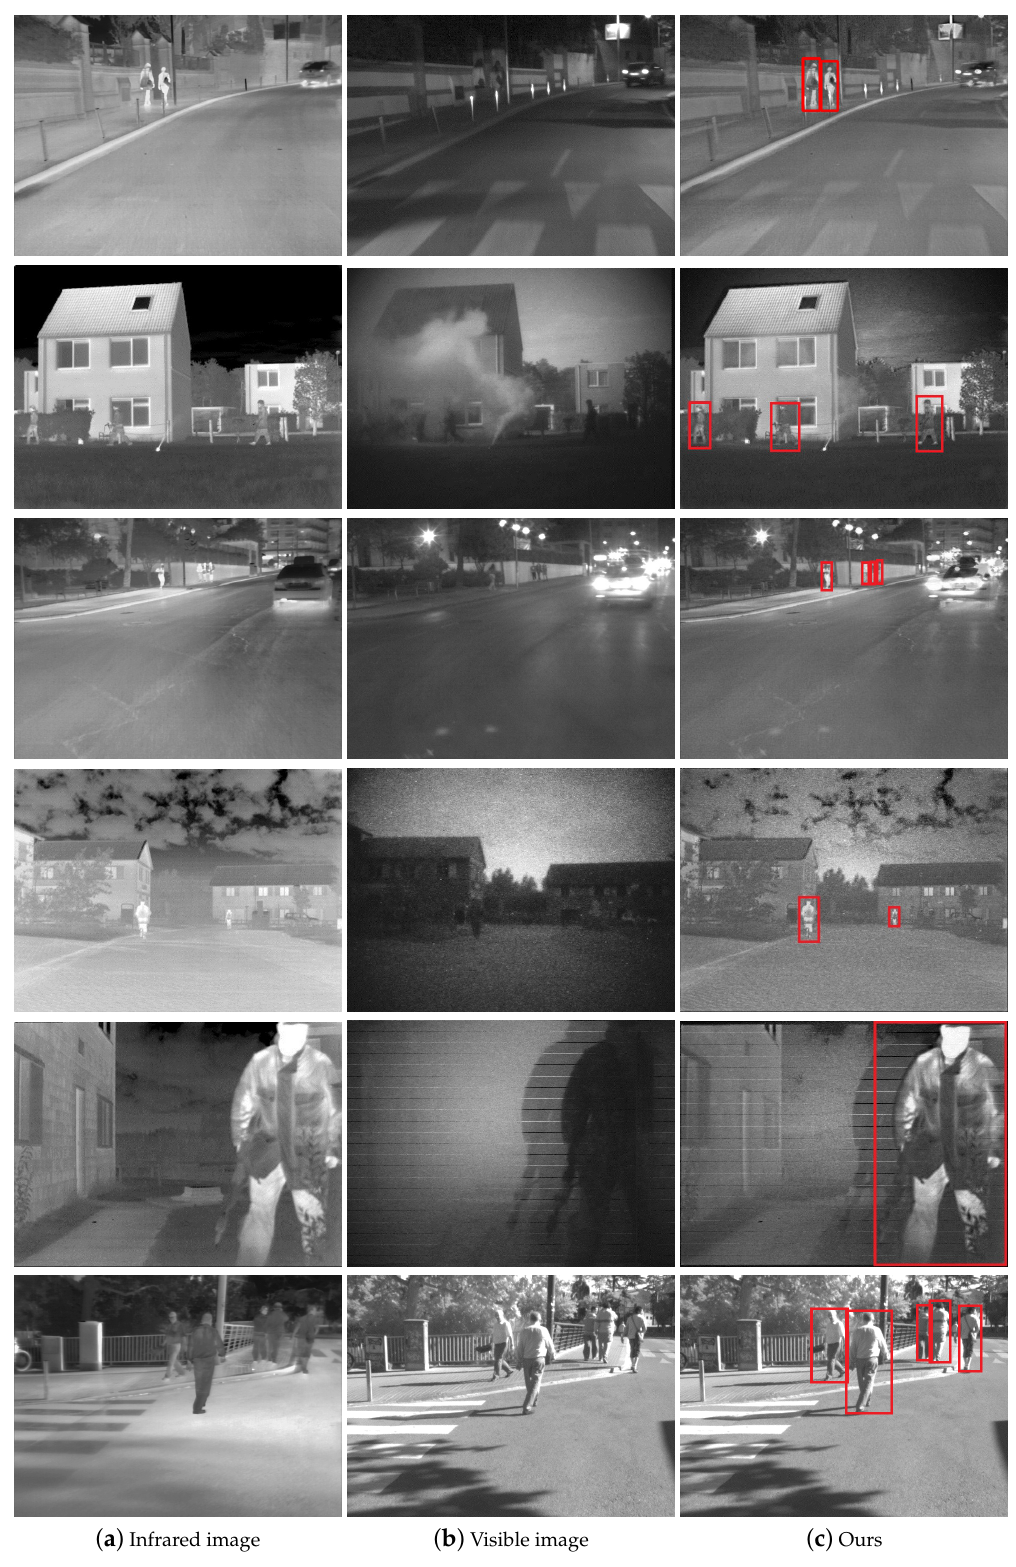
Figure 12. ( a – c ) Some detection results from our detection network. In order to better display the results, the detection results are shown on the fused images. The images in the first three rows have very low contrast; the objects in the fourth row are relatively small; the object in the fifth row is relatively large; and the images in the last row are in the